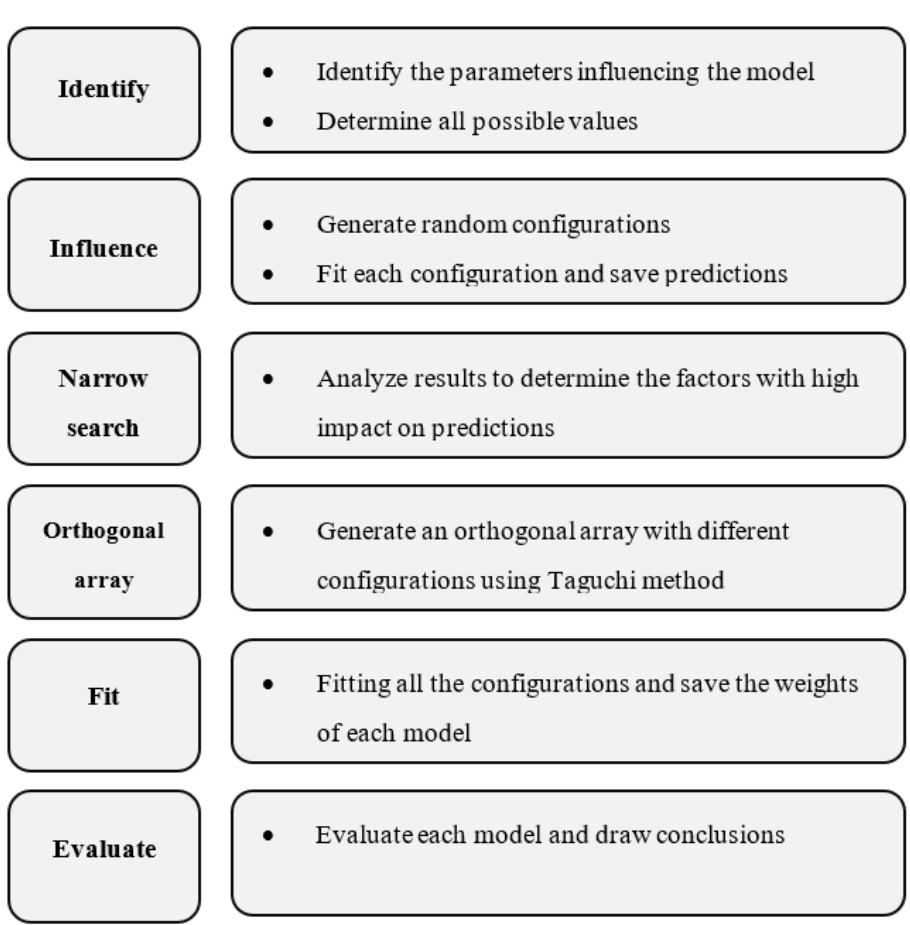
Figure 4. Diagram of the Taguchi method.